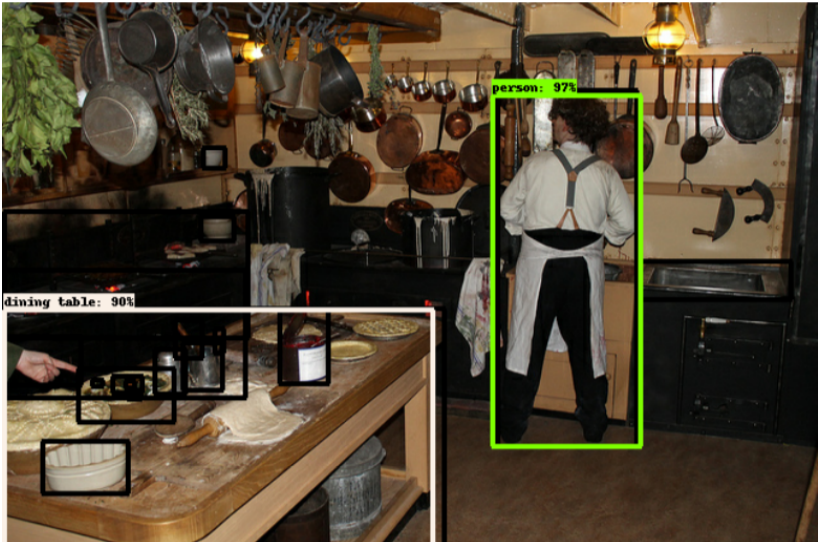
Figure 4. Example of objects detection. Several boxes are identified corresponding to different objects. Only those with confidence values higher than 60% are labeled and